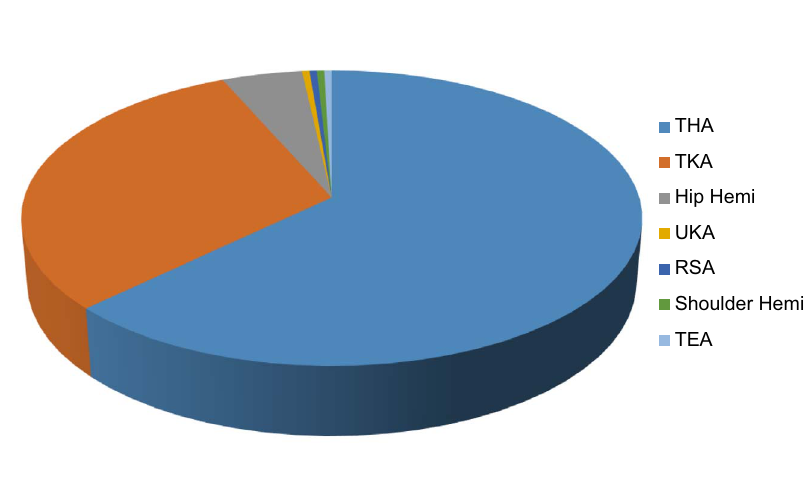
Figure 1. Location of periprosthetic